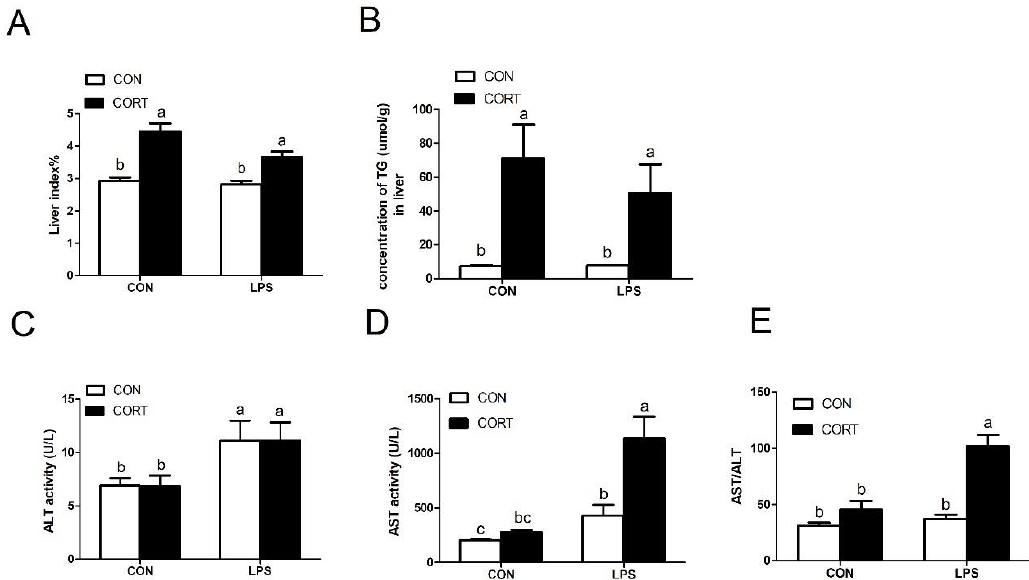
Figure 3. Level of liver index and biochemical parameters. ( A ) Liver index; ( B ) Hepatic TG content;